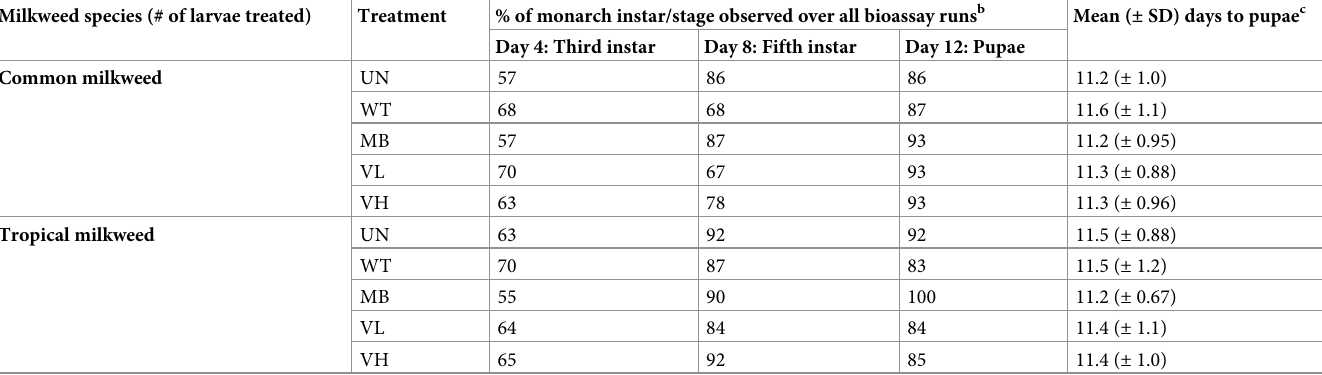
Table 3. Monarch larval development following treatment with Varroa-active dsRNA and one positive and two negative controls a . Milkweed species (# of larvae